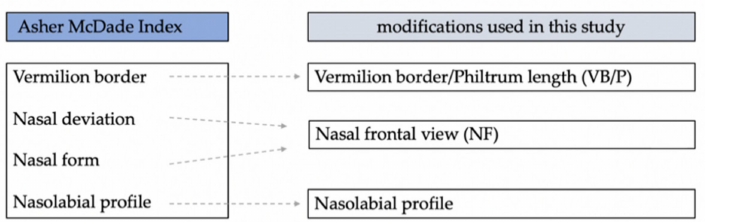
Figure 3. To show the parameters assessed within the original description of the Asher–McDade Index and the modifications used in this study [19,21,22].